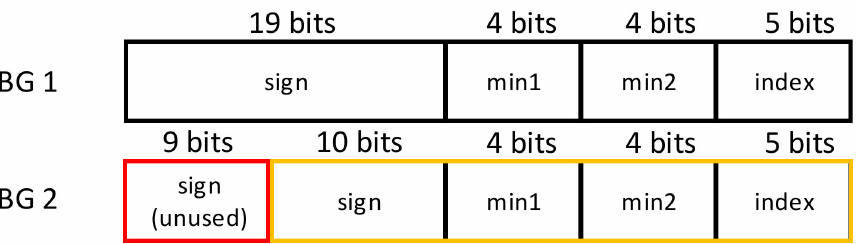
Figure 7. Bit assignment of the extrinsic message of the proposed dual-mode LDPC decoder for the 5G NR BGs 1 and